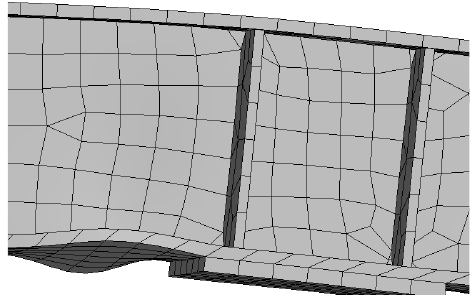
Figure 12. Buckling of the steel beam of CSB-1.